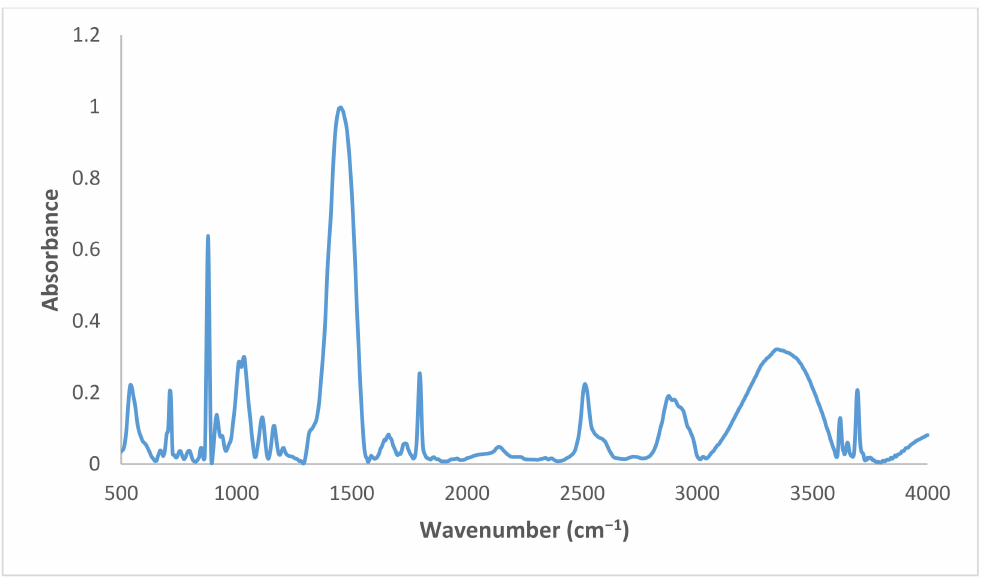
Figure 1. Fourier-transform infrared spectra of the deinking paper sludge